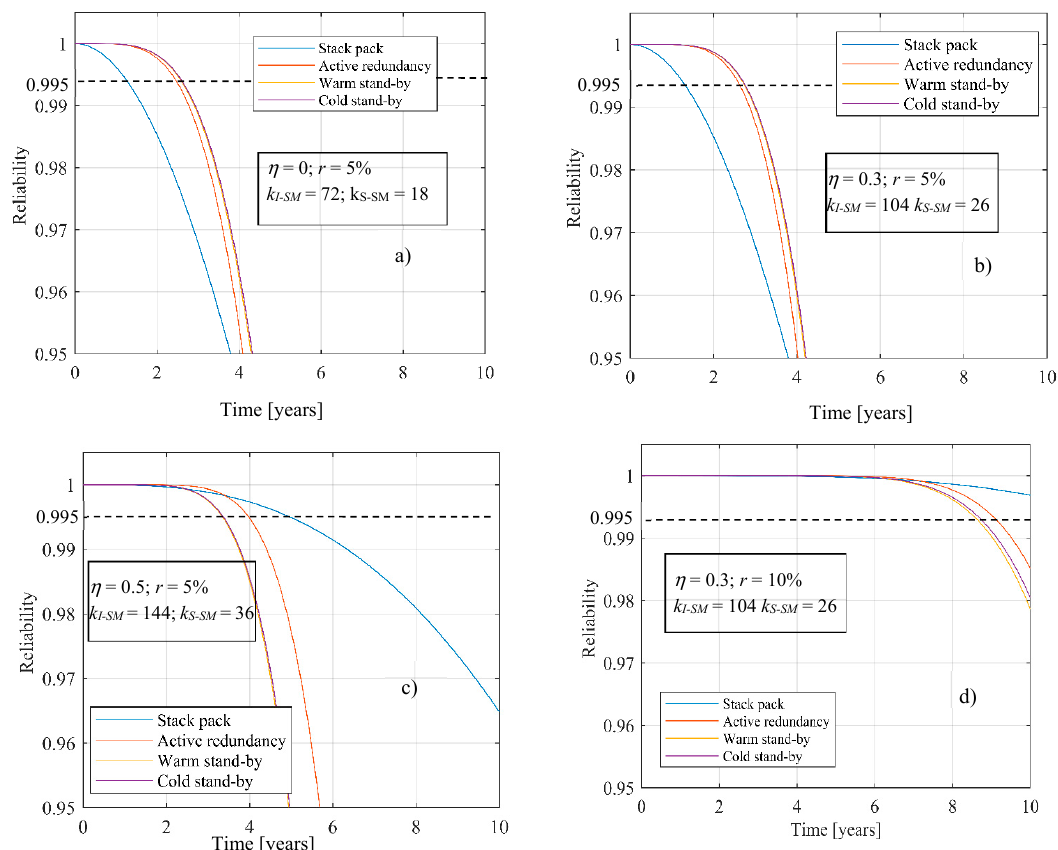
Figure 11. R(t) of the converter as a function of r, k I-SM , k S-SM , and η : ( a ) r = 5%, k I-SM = 72, k S-SM = 18 and η = 0; ( b ) r = 10%, k I-SM = 104, k S-SM = 26 and η = 0.3; ( c ) r = 5%, k I_SM = 144, k S-SM = 36 and η = 0.5; ( d ) r = 10% k I_SM = 104, k S-SM = 26, η = 0.3 .